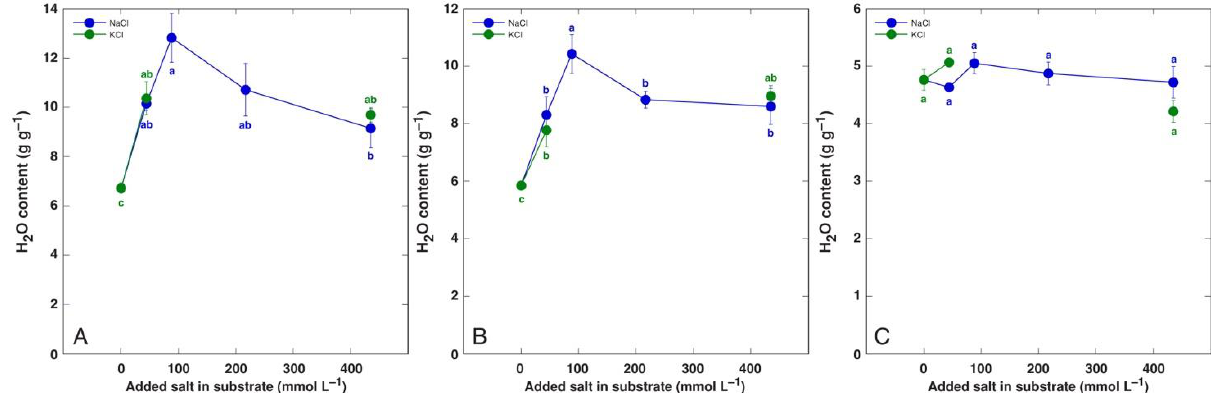
Figure 4. Tissue water content of old leaves ( A ), young leaves ( B ), and roots ( C ) of Beta vulgaris subsp. maritima plants cultivated in soil and treated with different doses of NaCl and KCl. Different letters indicate statistically significant ( p < 0.05) differences between treatments. Figure is taken from Ievinsh et al., 2022 [184].